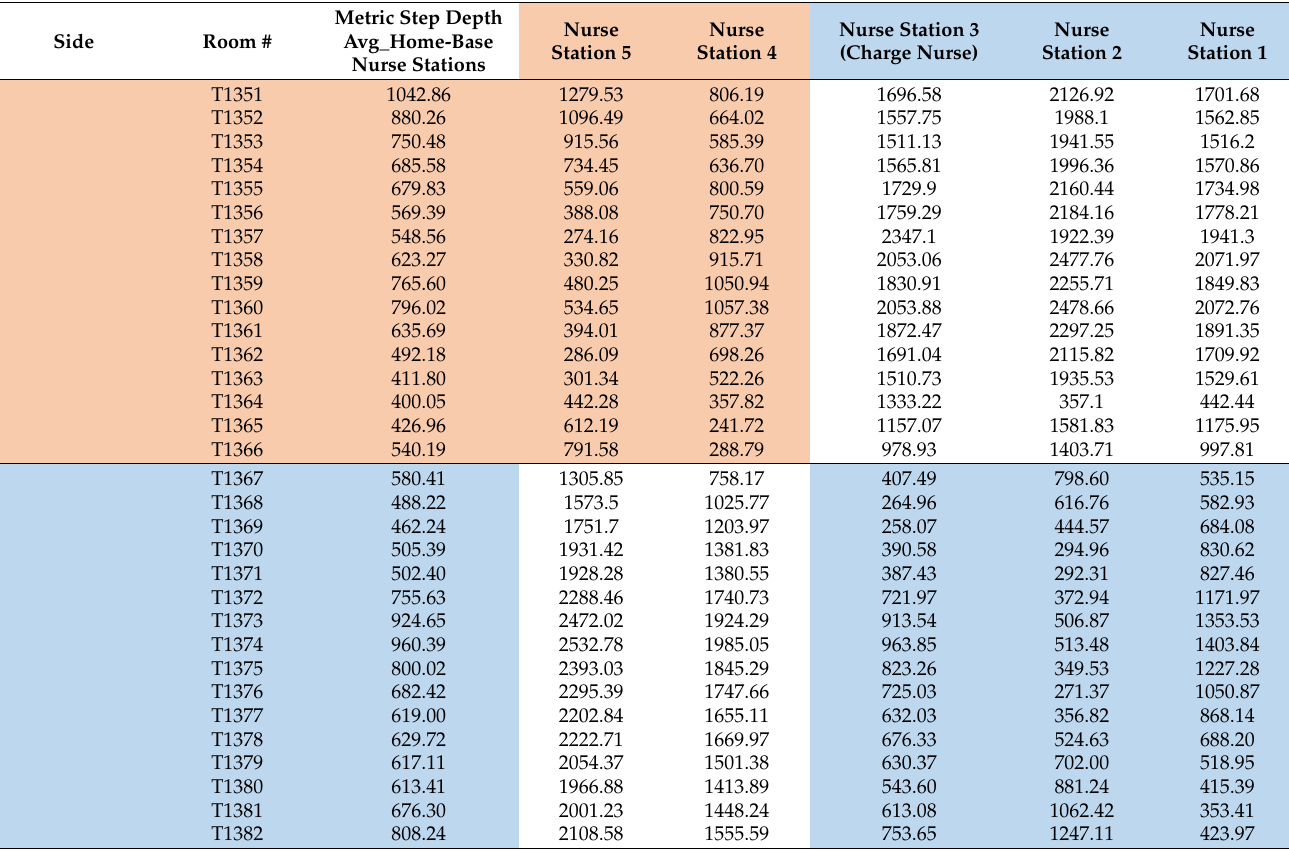
Table A2. Metric step depth for each room in relation to each nurse station and home-base